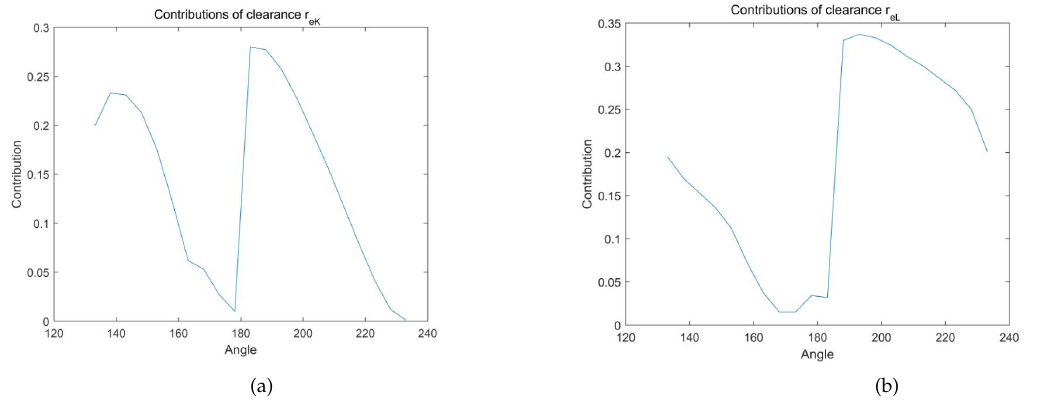
Figure 8. ( a ) The contributions of r eK ; ( b ) The contributions of r eL